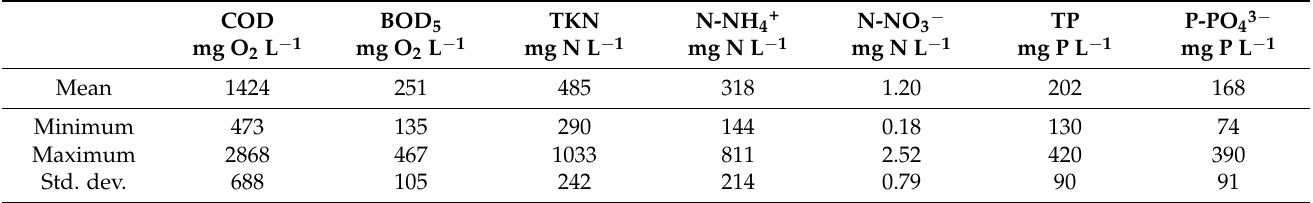
Table 1. The characteristics of rejected water from ATAD process (n = 8), WWTP 1.